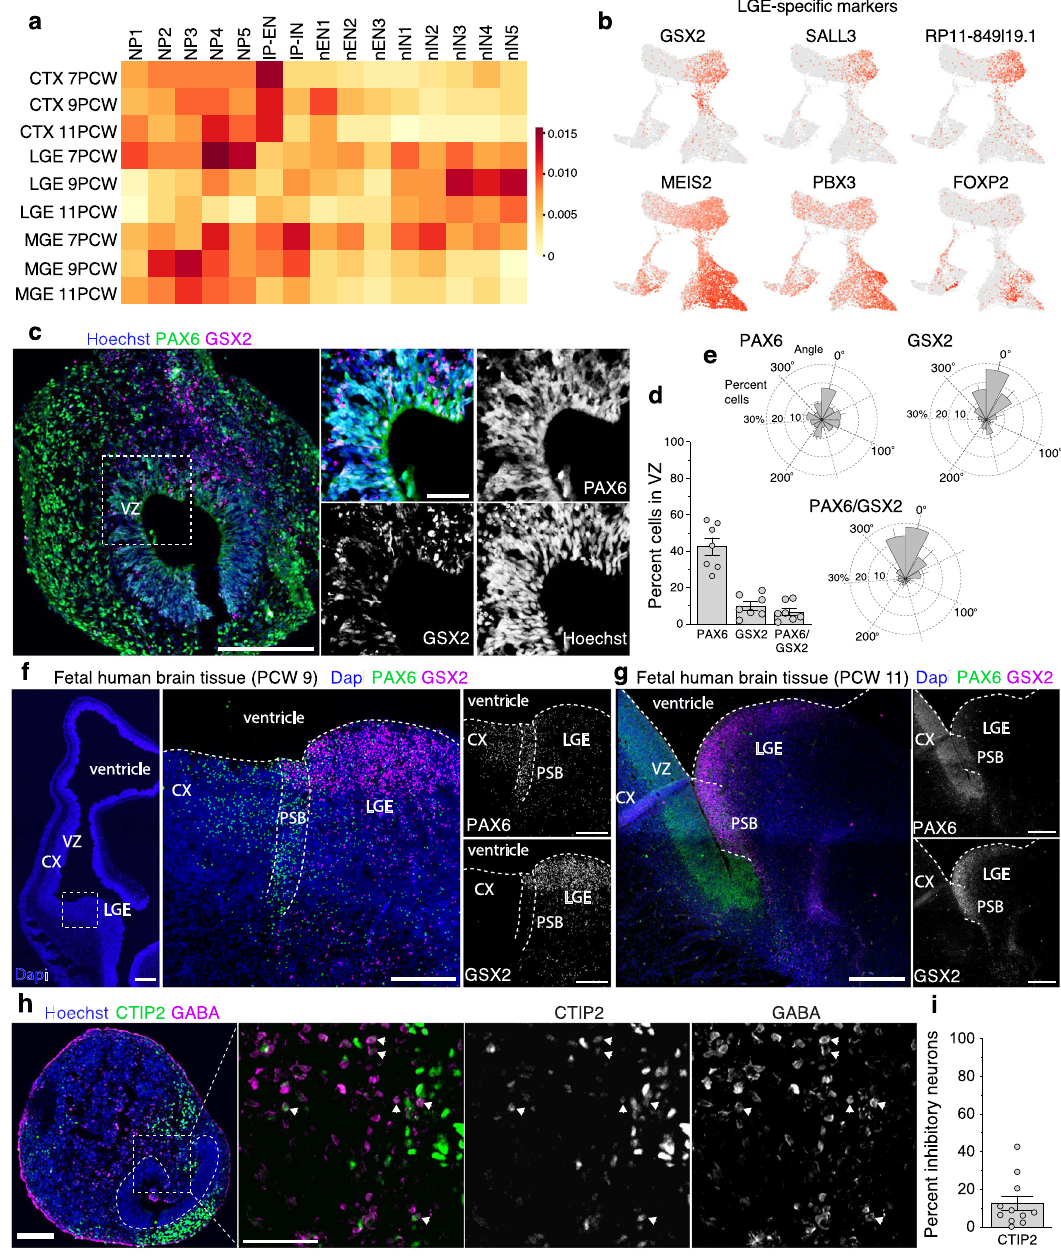
Fig. 4 | LGE-like origin of inhibitory neurons in 1-month-old SNR-derived organoids.a HeatmapvisualizationoftheJaccardsimilarityindexbetweenunique DEGs in the human fetal neocortex (CTX), lateral ganglionic eminence (LGE) and medial ganglionic eminence (MGE) at 7, 9, and 11 post-conception weeks (PCW) 8 and those in different clusters of 1-month-old SNR-derived organoids (Supple- mentary Data4). b UMAPvisualization of expression of LGE-speci fi cmarkergenes, GSX2, SALL3, RP11-849l19.1, MEIS2, PBX3, and FOXP2 in 1-month-old organoids. c Organoid sections immunostained for PAX6 and GSX2. d Quanti fi cation of per- centages of PAX6-, GSX2- and PAX6/GSX2-expressing cells in the lumen- surrounding VZ ( n =7 organoids/1 – 2 sections per organoid in two batches from